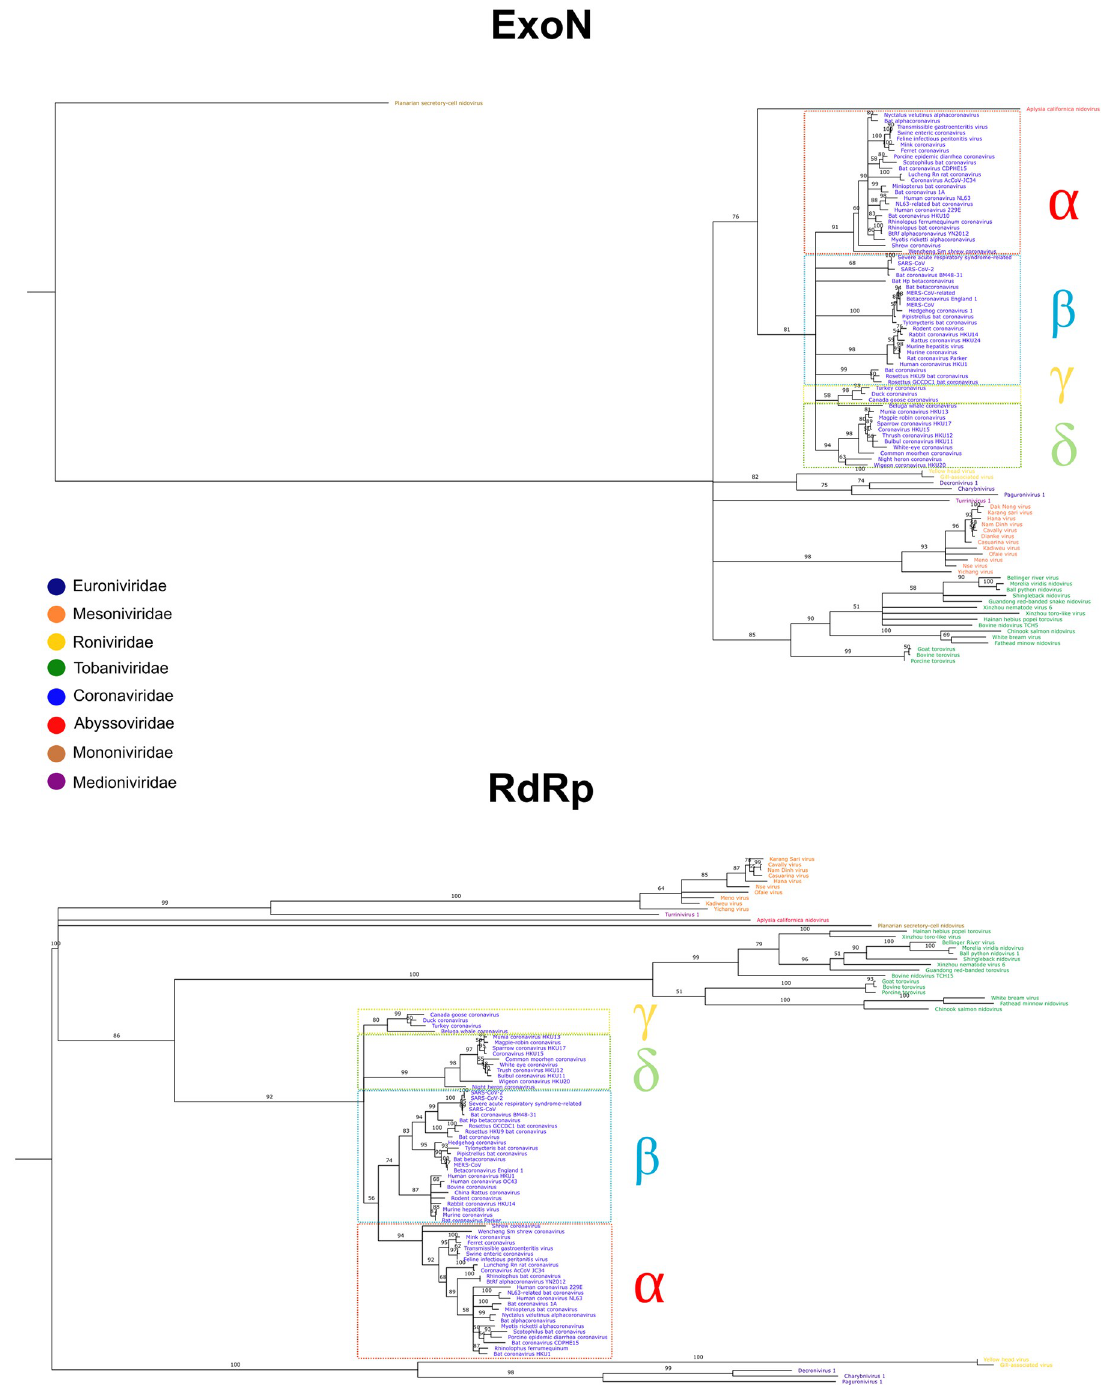
Fig 3. Nidovirus RdRp and ExoN maximum-likelihood phylogenies. The colors in the names of the viral species correspond to the families they belong to. The Coronaviridae family has been divided in its corresponding genuses: alphacoronavirus ( α ), betacoronavirus ( β ), deltacoronavirus ( δ ), and gammacoronavirus ( ɣ ). Bootstraps branches with < 50% have been collapsed.